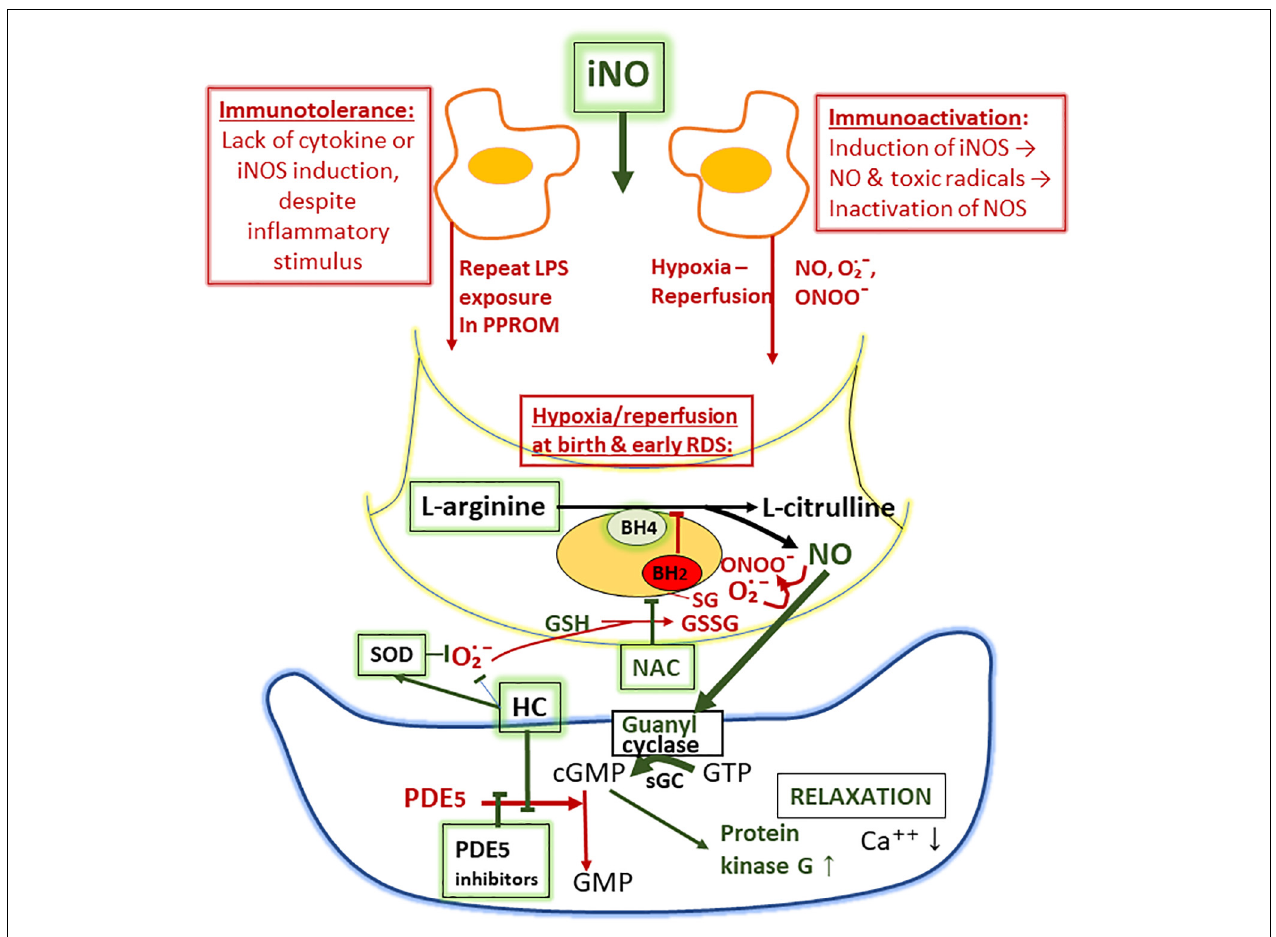
FIGURE 2 | Proposed mechanisms of suppression of nitric oxide (NO) synthesis in the lung as a sketch depicting macrophage (above) , endothelial cell (middle) , and smooth muscle cell (below) . The lack of NO synthesis is proposed to be due to (i) failure of iNOS synthesis due to immunotolerance, associated with inflammatory insults by prolonged rupture of fetal membranes and (ii) oxidant-induced inactivation of endothelial NO synthase (eNOS) involving glutathionylation, resulting in diversion of the NO synthetase (NOS)-catalyzed NO production to superoxide (O 2 •− ) production (uncoupling). Superoxide converts NO to toxic peroxynitrite (ONOO − ). Tetrahydrobiopterin (BH4), an essential co-factor of eNOS, may also be oxidized to BH2 upon inactivation of eNOS during ischemia-reperfusion injury. Phosphodiesterase-5 (PDE5) inhibitors (sildenafil), hydrocortisone (HC; inhibits PDE5 synthesis and the formation of